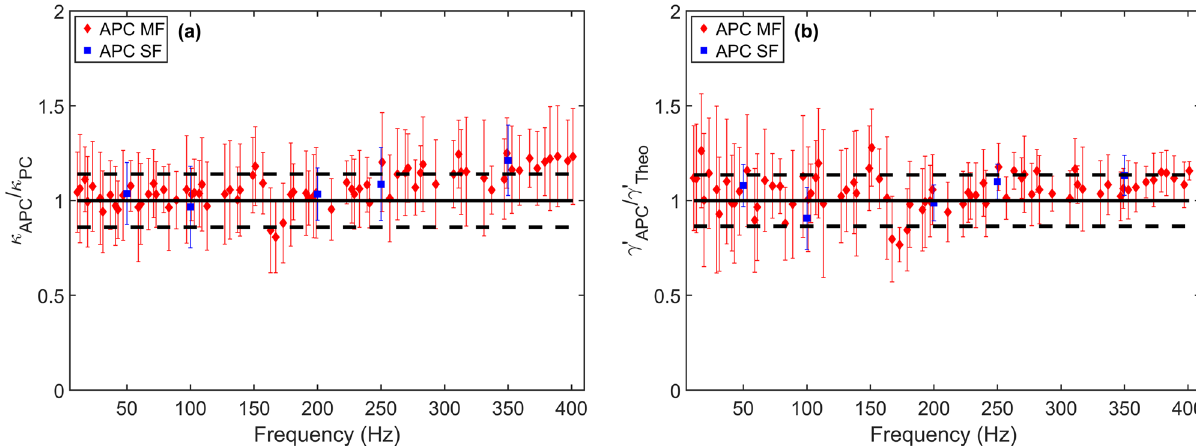
Figure 2. Results from measurements performed with 1 μm-diameter silica beads in water. ( a ) Trap stiffness κ APC obtained by APC compared with the reference trap stiffness κ PC derived with the PC as a function of the driving frequency. Multi-frequency measurements with prime numbers are compared to consecutive single- frequency measurements. ( b ) Real part of the friction retardation spectrum γ ′ APC resulting from single- and multi-frequency APC measurements compared with the theoretical value from Stoke’s law γ ′ Theo